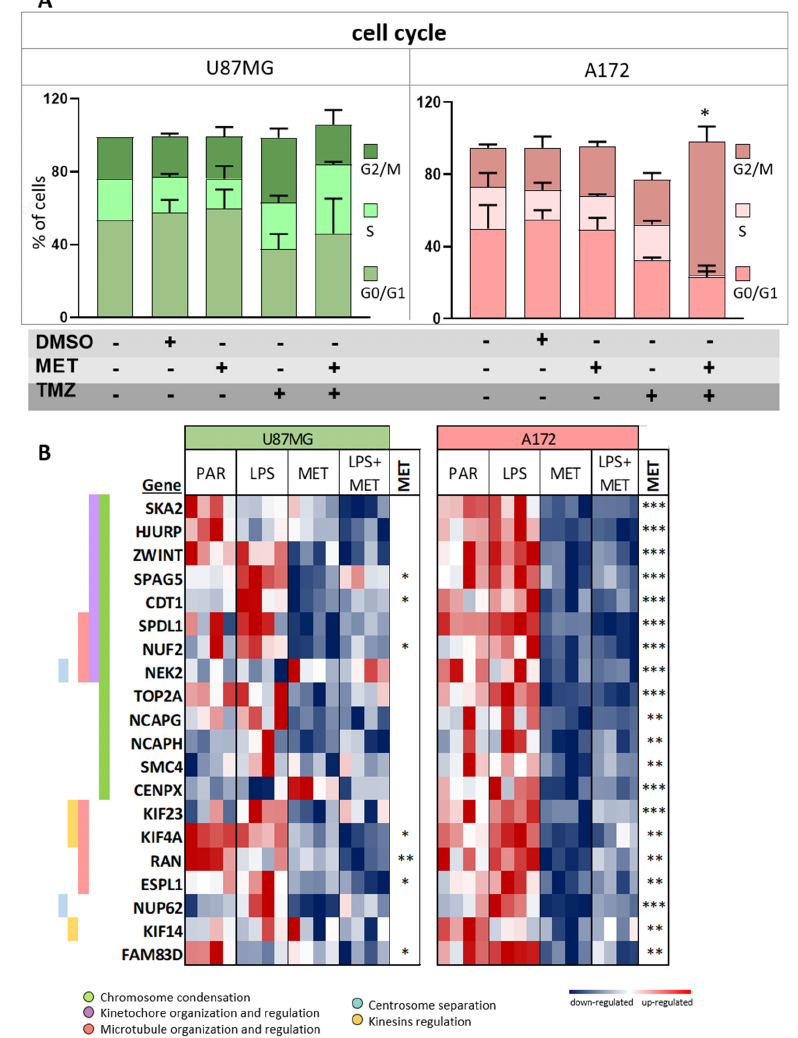
Figure 5. Cell cycle analysis and expression of genes related to chromosome segregation. ( A ) Cell cycle analysis for U87MG and A172 after MET and TMZ single and combined treatments. The bars represent each treatment condition. (*) p < 0.0001, two − way ANOVA post hoc Tukey test. G0/G1 phase (bottom bar), S phase (medium bar), G2/M phase (top bar); and ( B ) heatmap of chromosome segregation-related gene expressions after LPS and MET single and combined treatments in U87MG and A172 cells relative to non-treated controls. (*) p < 0.05, (**) p < 0.01, and (***) p < 0.001, Limma t − test for MET in comparison to PAR.